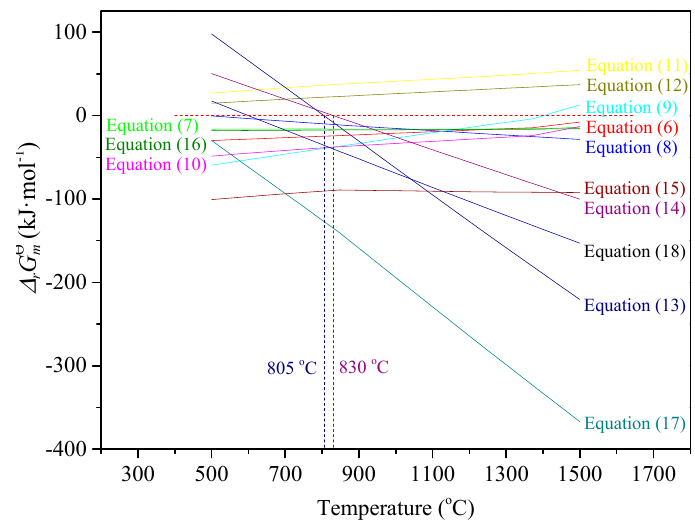
Figure 5. Calculations of Gibbs energy changes of Equations (6) – (18) by FactSage7.0.